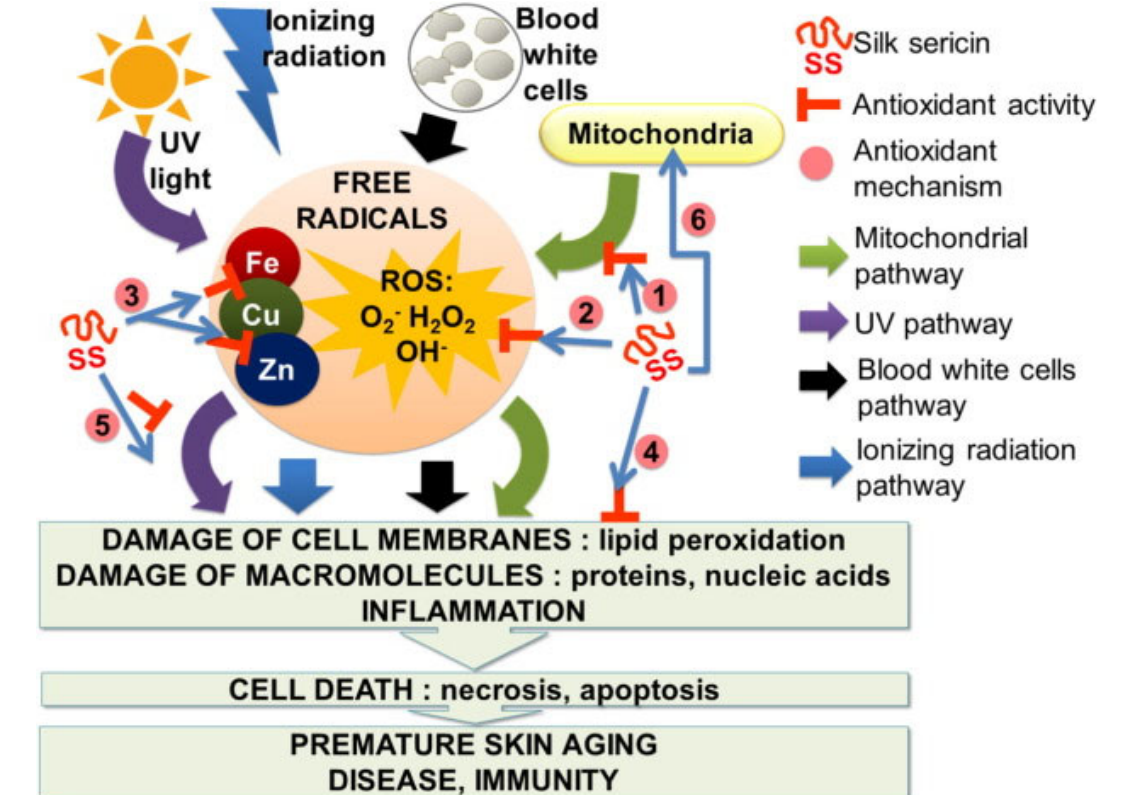
Figure 7. Mode of sericin antioxidant activity. ROS = reactive oxygen species; 1 = enrichment of antioxidant enzymes, i.e., superoxide dismutase and glutathione peroxidase; 2 = ROS scavenging; 3 = chelation of transition metals; 4 = prevention of lipids peroxidation and inflammation; 5 = inhibi ‐ tion of UV ‐ induced apoptosis and sunburn effects on the skin; 6 = increased level of NAD+ and improved detoxification via oxidation. Reproduced with permission from Lamboni et al. [3],